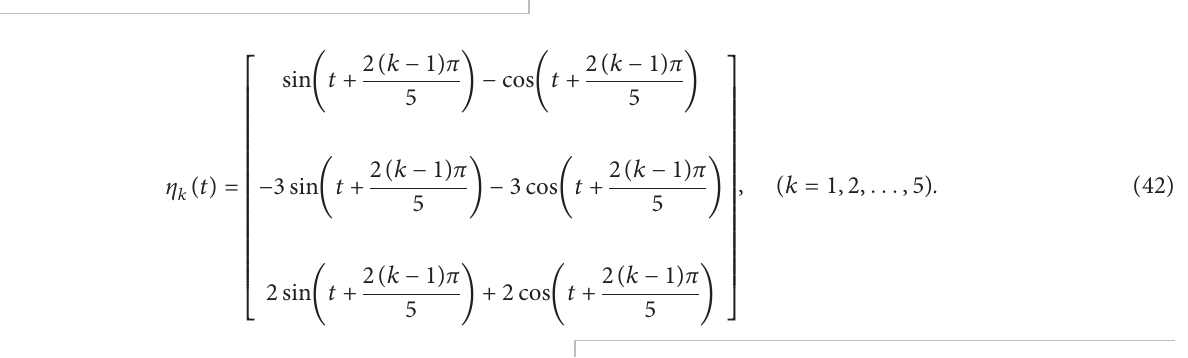
Figure 2 shows the trajectories of ς k ( t ) , ( k � 1 , 2 , . . . , 5 ) , where the curves formed by circle markers are the trajectories of the collaborative state of the leader. In Figure 3, the state snapshots of the leader and five where the leader is depicted by pentagrams and